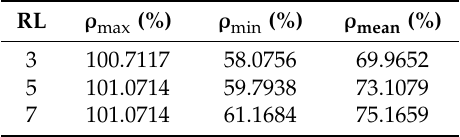
Table 4. Average performance results with different